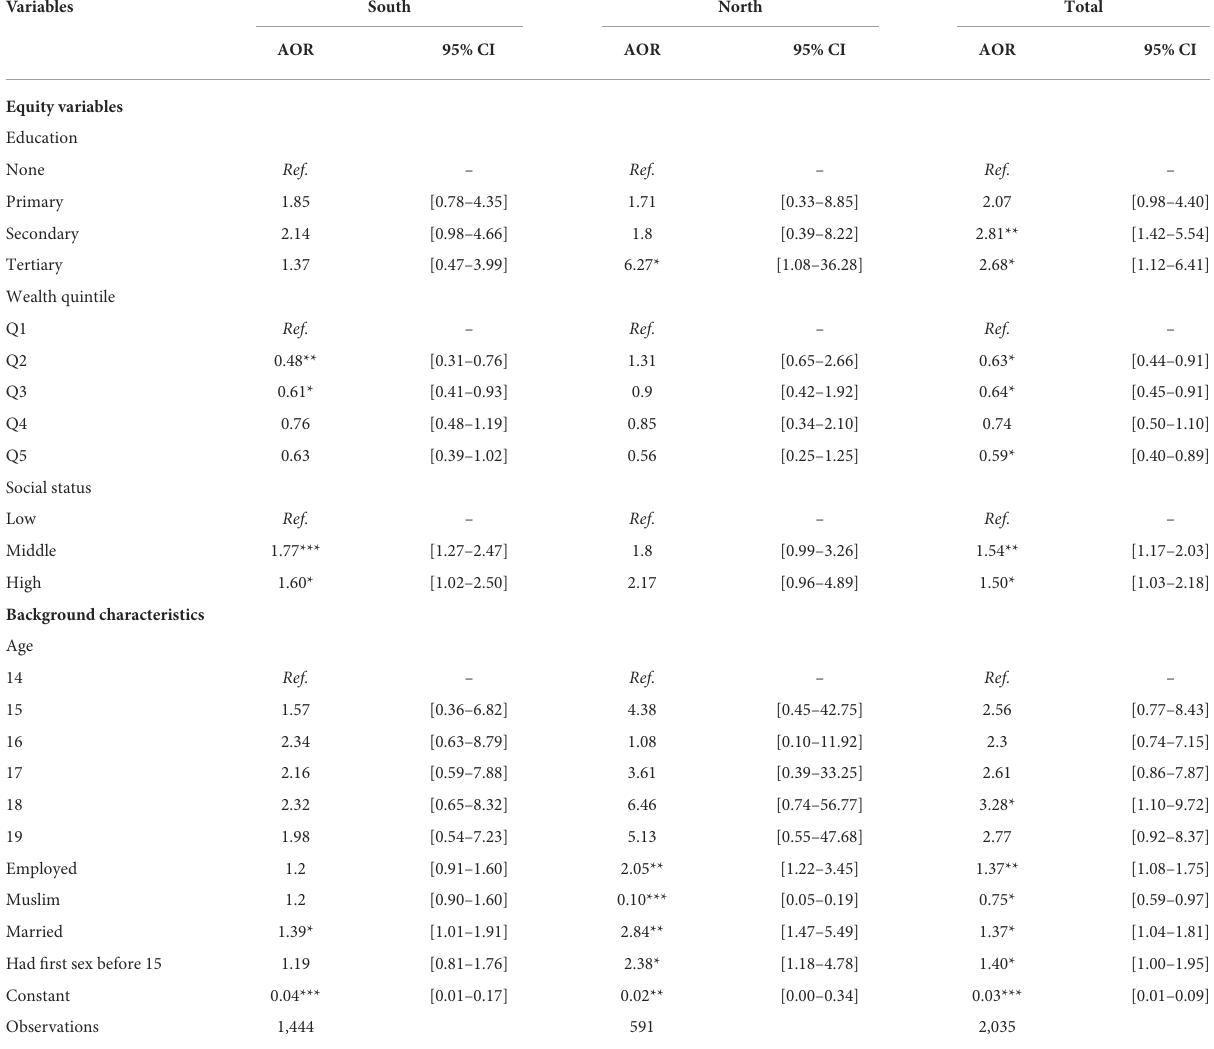
TABLE 3 Multivariable logistic regression models of associations between background characteristics, equity variables, and modern contraceptive use of adolescent girls in selected urban slums in